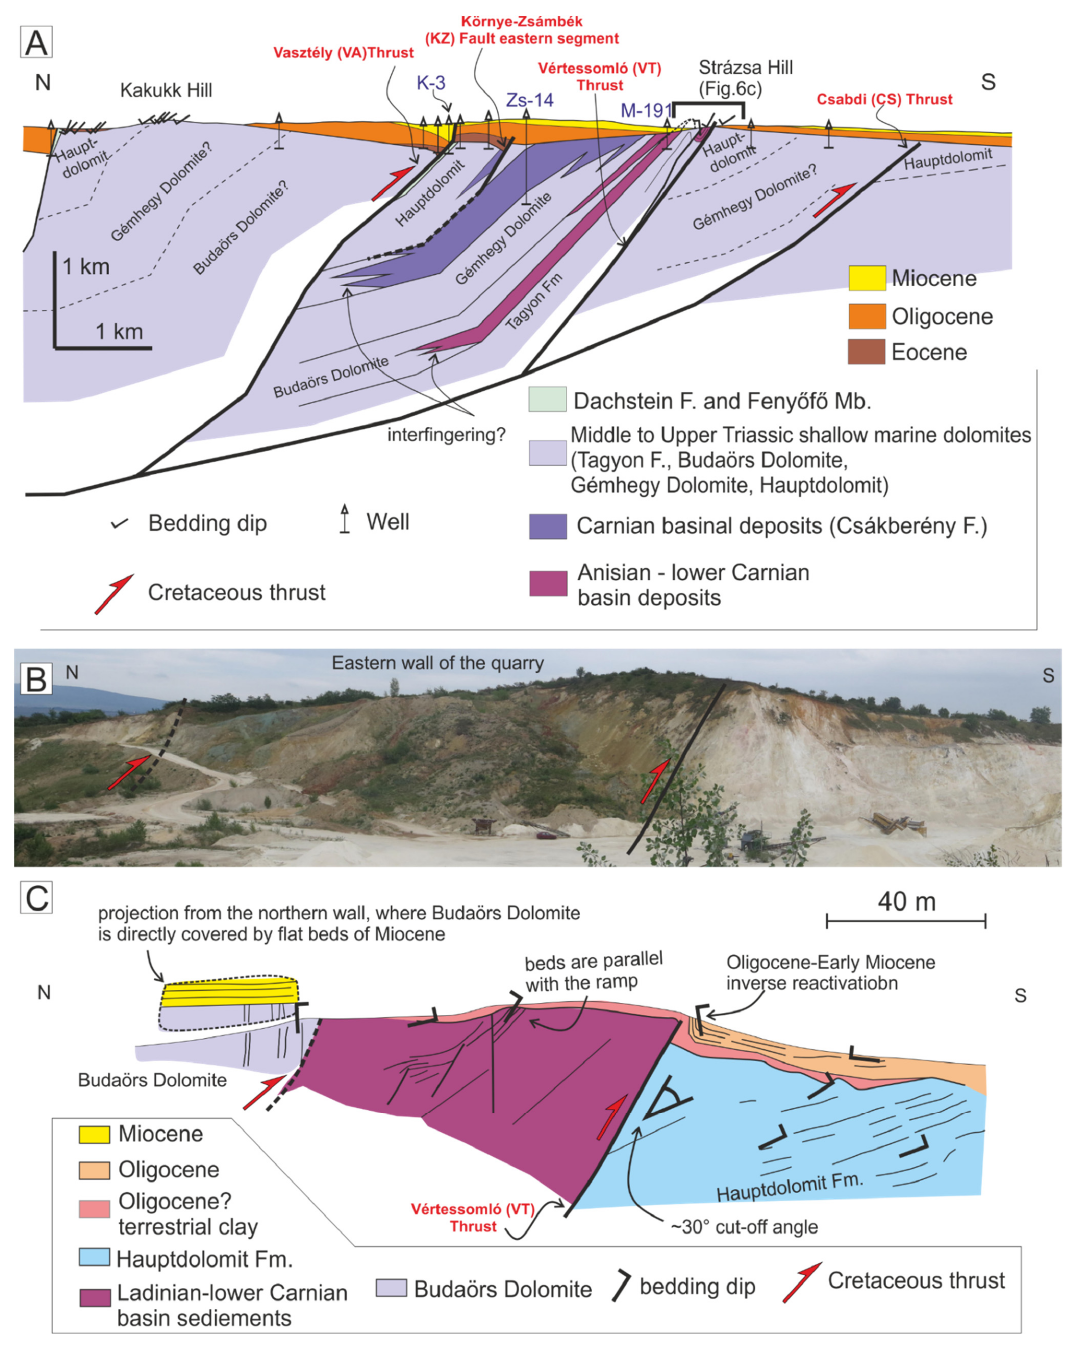
Figure 6. ( A ) N-S striking cross section across the study area, showing the imbrication of Triassic formations. For the trace of the section, see Figure 4. ( B ) Photo of the eastern wall of the Strázsa Hill quarry, where the VT Thrust is exposed. ( C ) Geological cross-section along the eastern wall of the quarry. For the location of the outcrop, see Figures 5 and 7. The abbreviations “Fig.” refer to figures of this work.